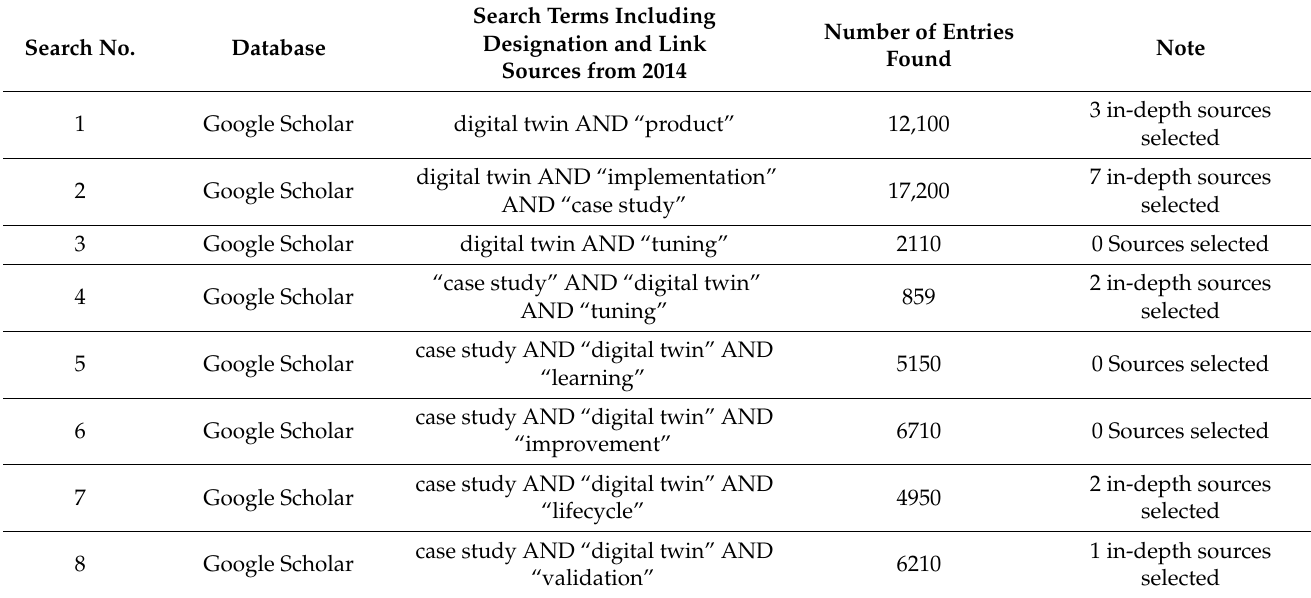
Table 1. Results when searching for empirical evidence concerning structured DT